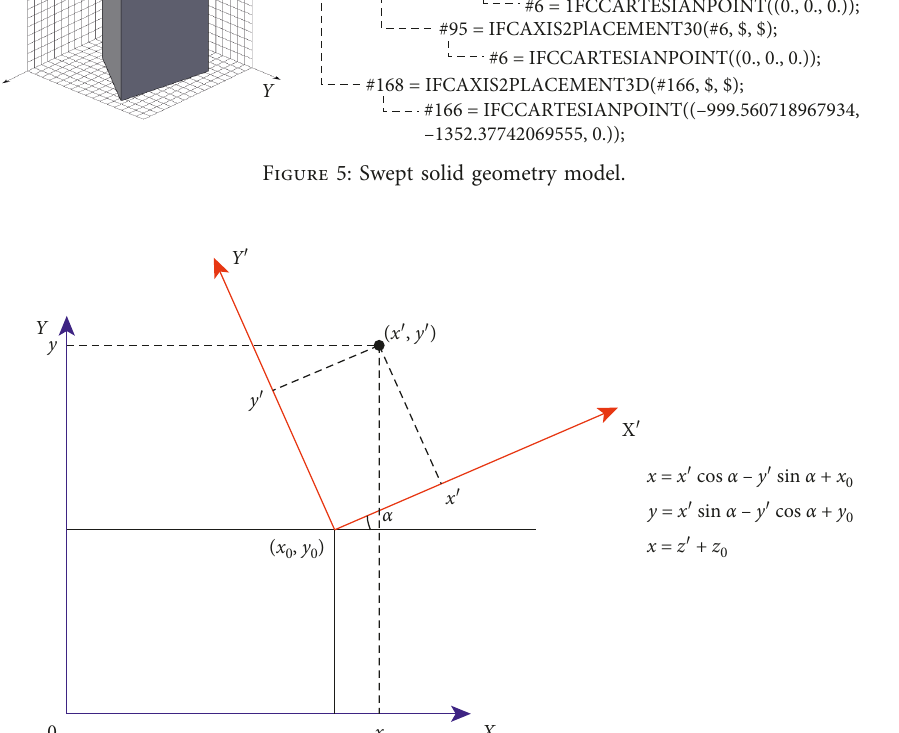
Figure 6: The transformation of coordinate systems.